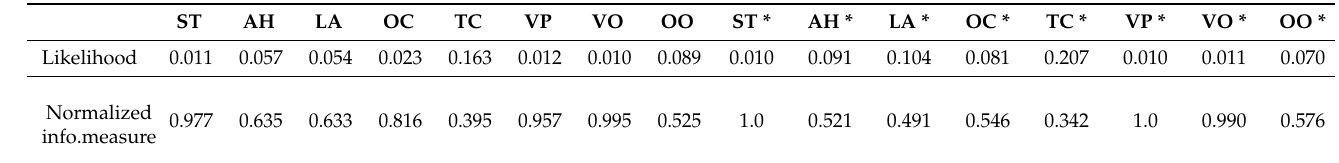
Table 4. DoTA Anomaly Class Probabilities and Values. An anomaly label with “*” indicates an event where the ego car is not involved (i.e., non-ego); otherwise, the event is ego-involved. ST AH LA